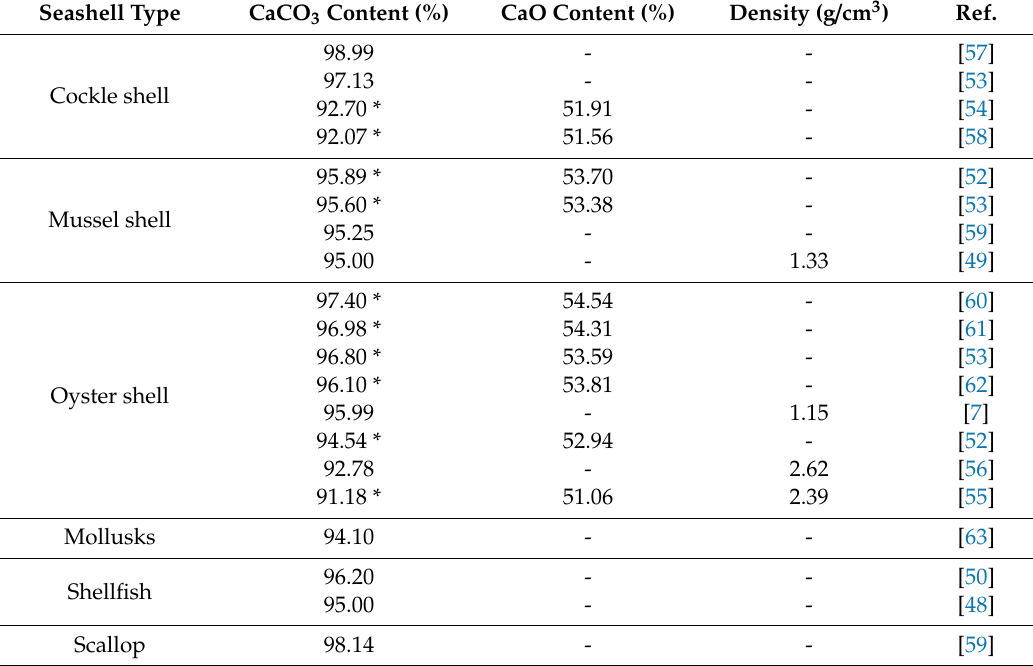
Table 2. CaCO 3 composition of seashells (*calculated based on Equation